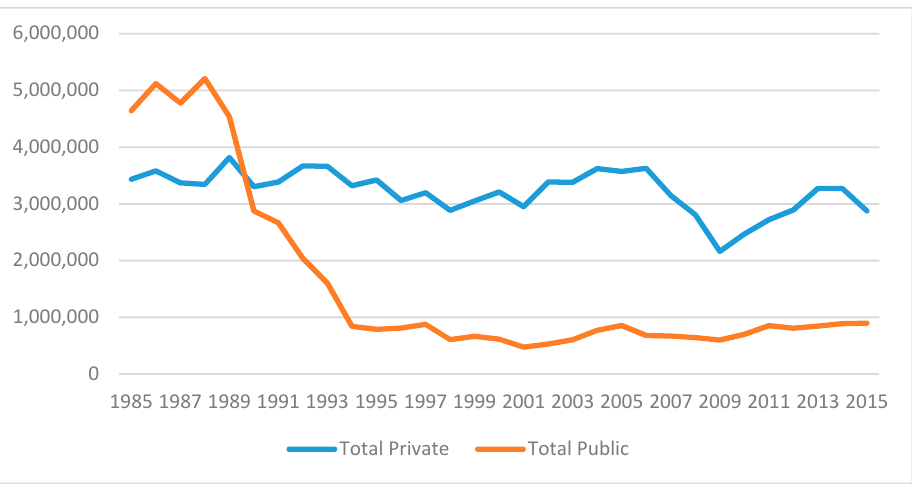
Figure 3. Timber Harvest in Oregon by Thousand Board Feet (1985–2015). Source: [52].